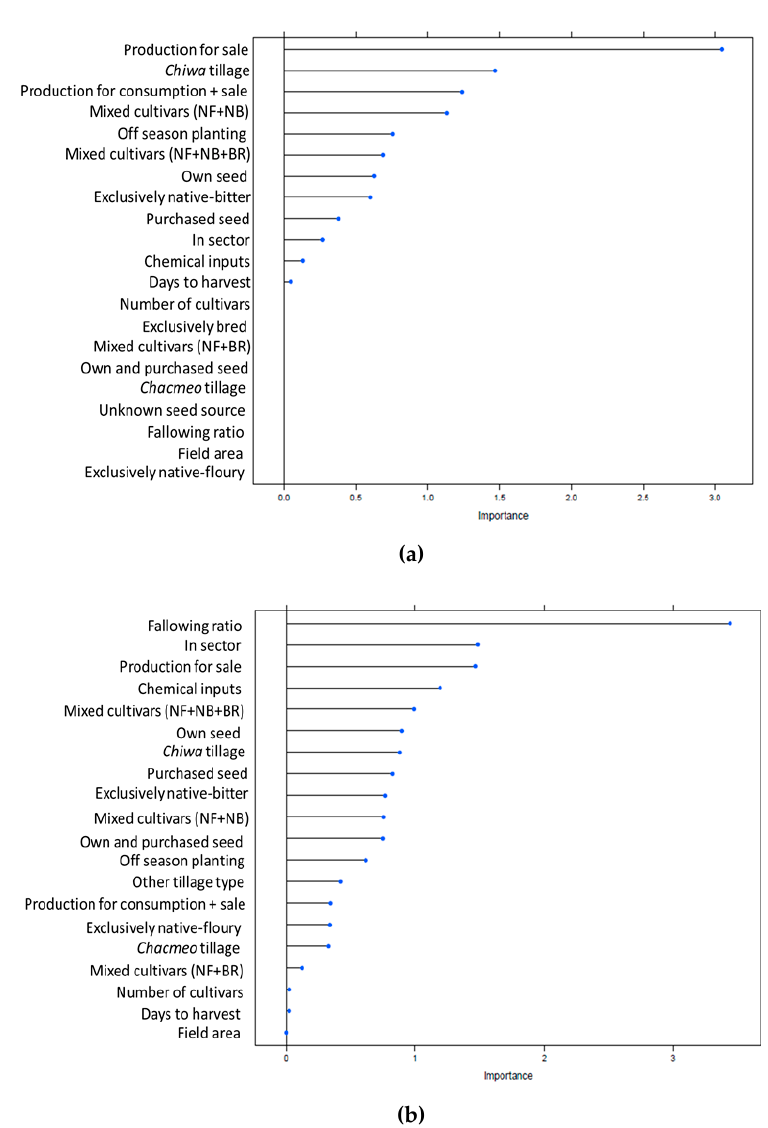
Figure 6. Farmer management associated variables listed in order of significance in differentiating ( a ), intermediate, and ( b ) high-altitude fields between landscapes.